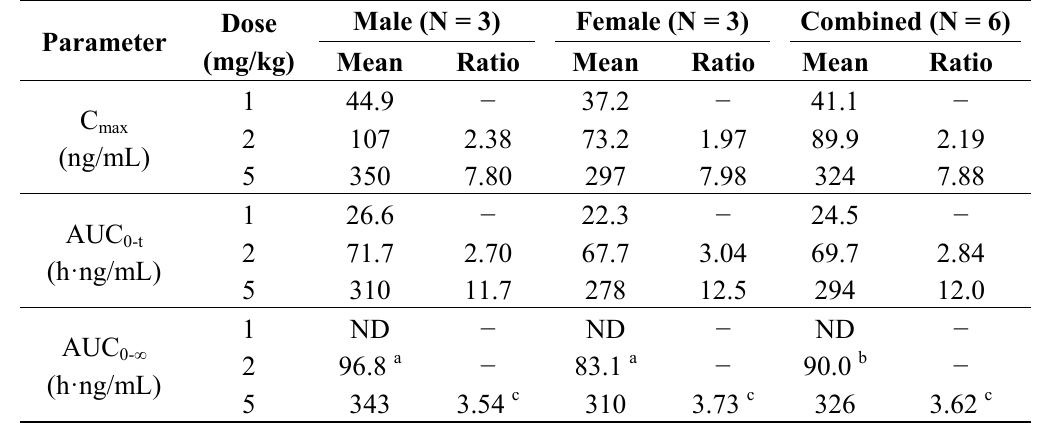
Table 4. Ratio of Mean AUC Level of BMEDA in Beagle Dogs after Intravenous Injection of BMEDA at 1, 2 and 5